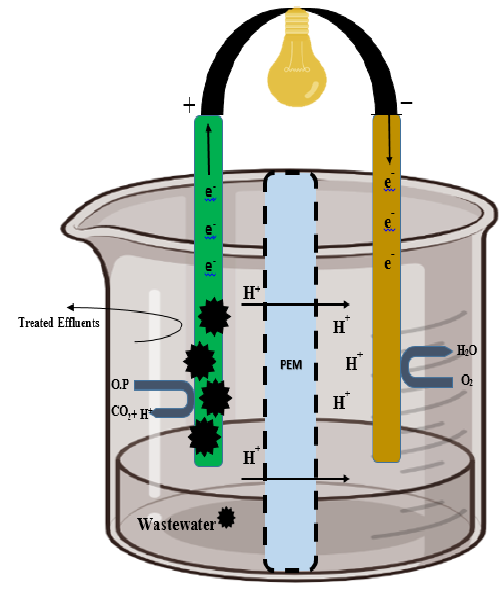
Figure 5. Wastewater with e ffl uents and organic pollutants is placed in anodic regions, where fungal oxidoreductase enzymes are deposited on the electrode. Carbon, electrons, and protons are gener- ated from the e ffl uents by oxidoreductase action and transferred to the cathode where the reduction of O 2 into water takes place. The external resistor between the anode and the cathode harvests the electricity easily. electricity